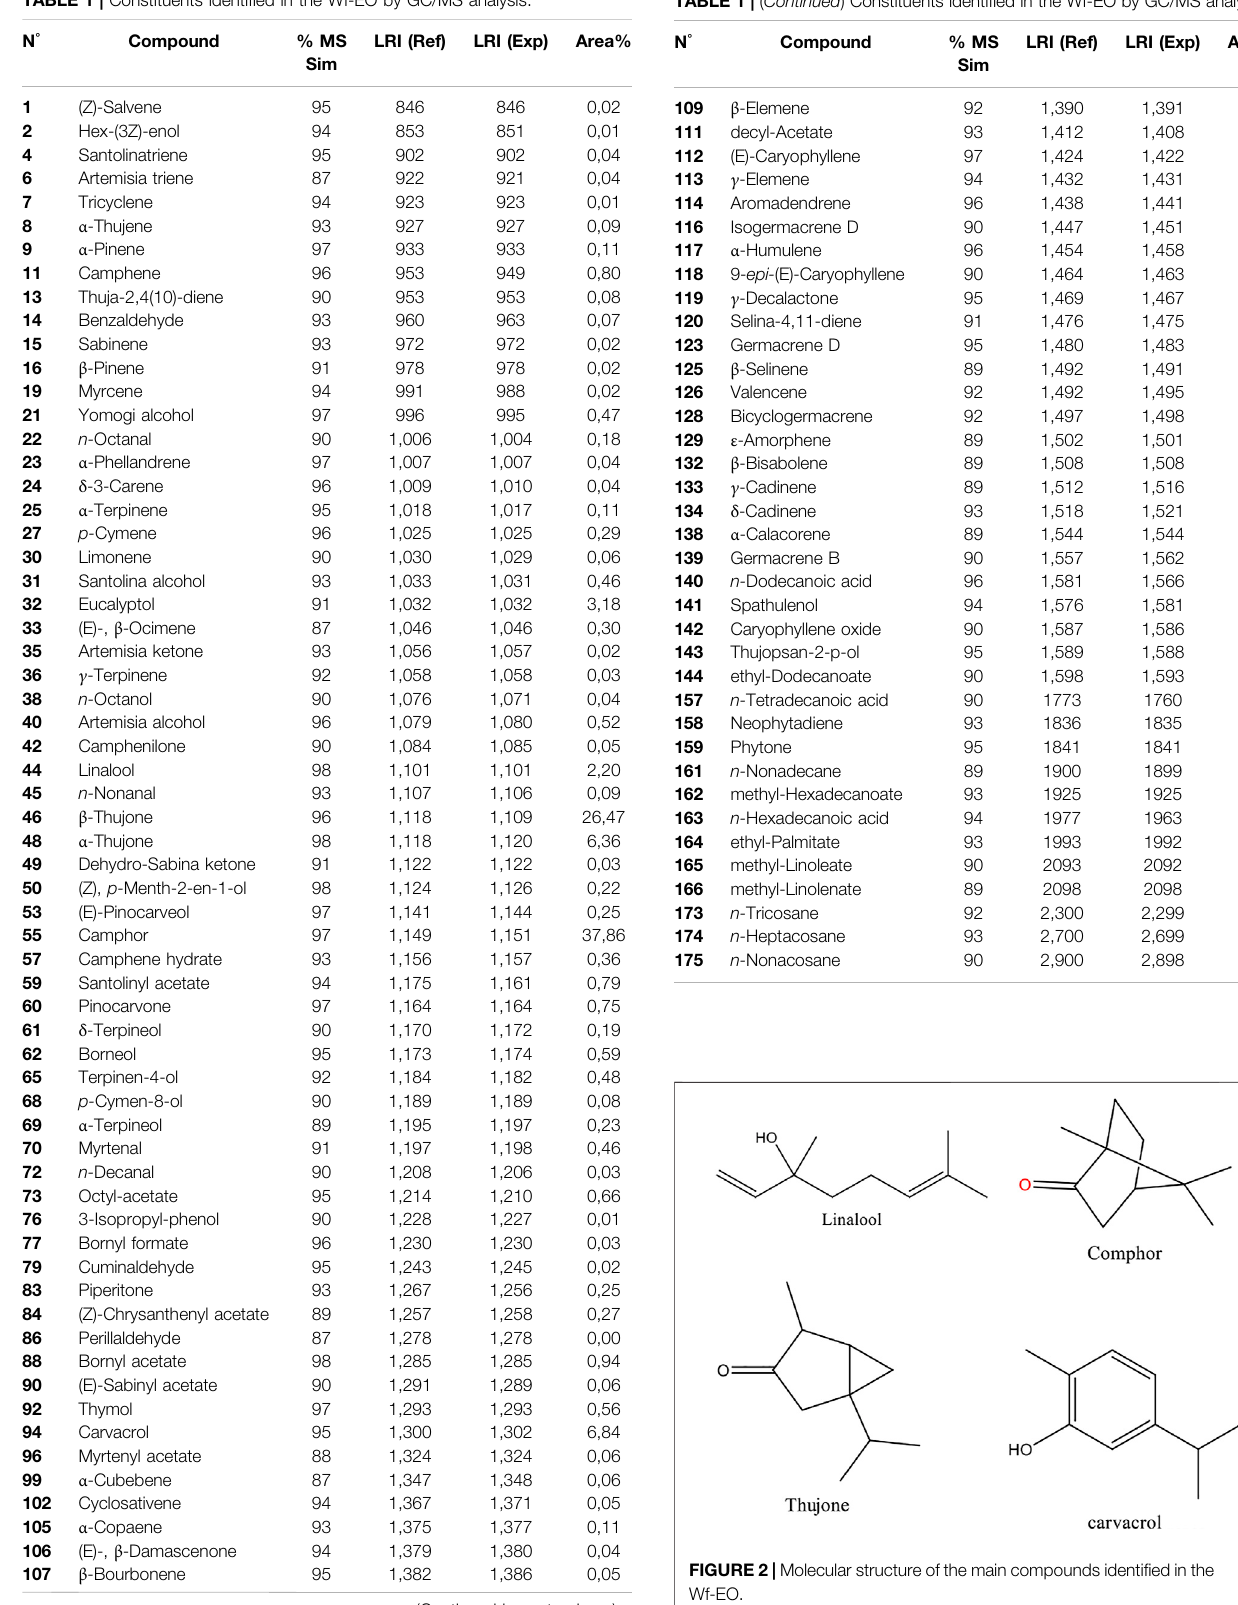
TABLE 1 | Constituents identi fi ed in the Wf-EO by GC/MS analysis.